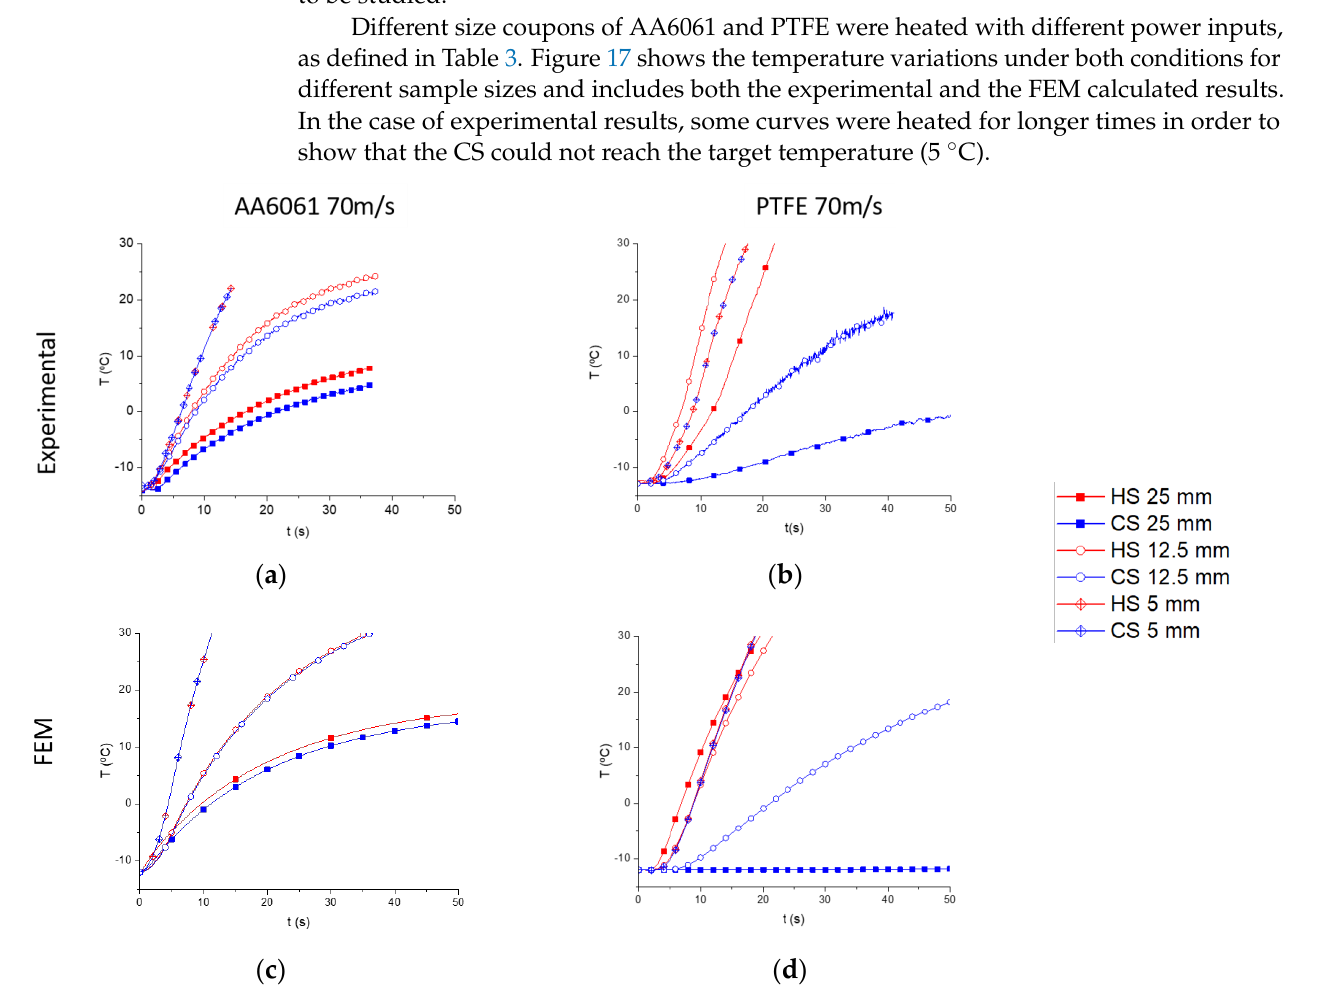
Figure 16. Heating times distribution.